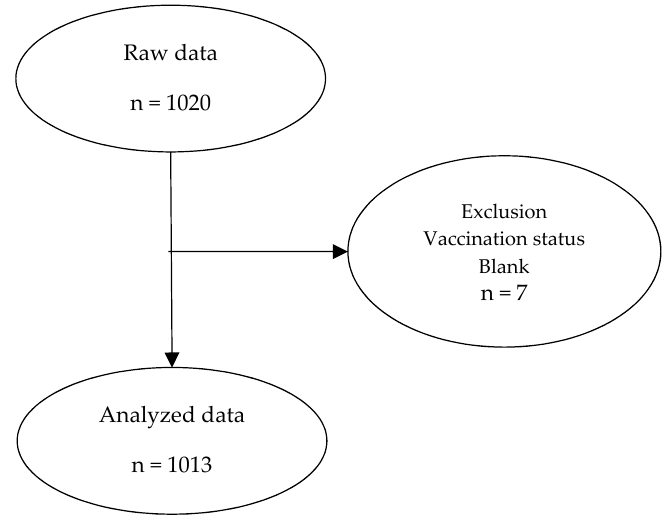
Figure 1. Analyzed Figure 1. Analyzed data